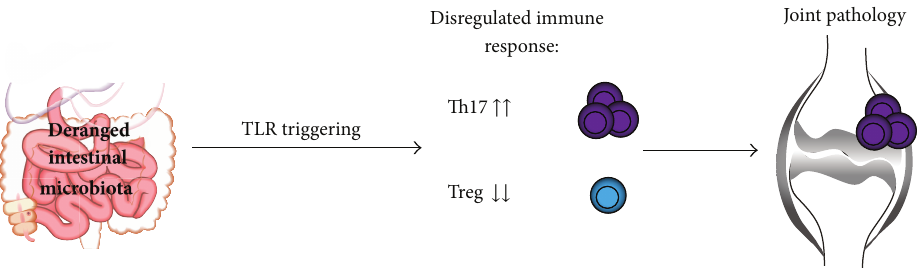
Figure 1: Exposure to deranged intestinal microbiota or a disregulated immune response to microbiota drives rheumatoid arthritis by promoting Th17 and deranging Treg